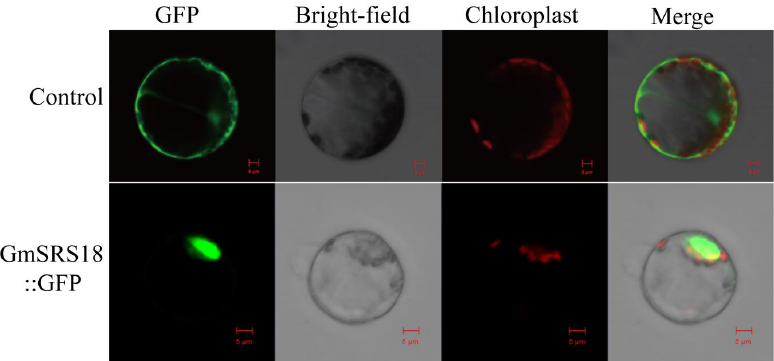
Figure 7. Subcellular localization of the soybean GmSRS18 protein. The picture above is a control and below is GmSRS18 protein. Results were visualized with confocal microscopy 16 h after transformation. Scale bars = 5